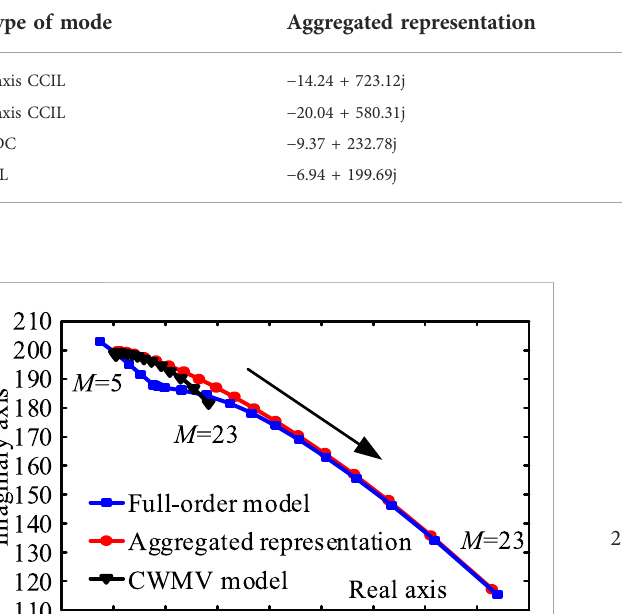
TABLE 3 Oscillation modes of the cluster of fi ve inverters in daisy-chain connection (case study 3).